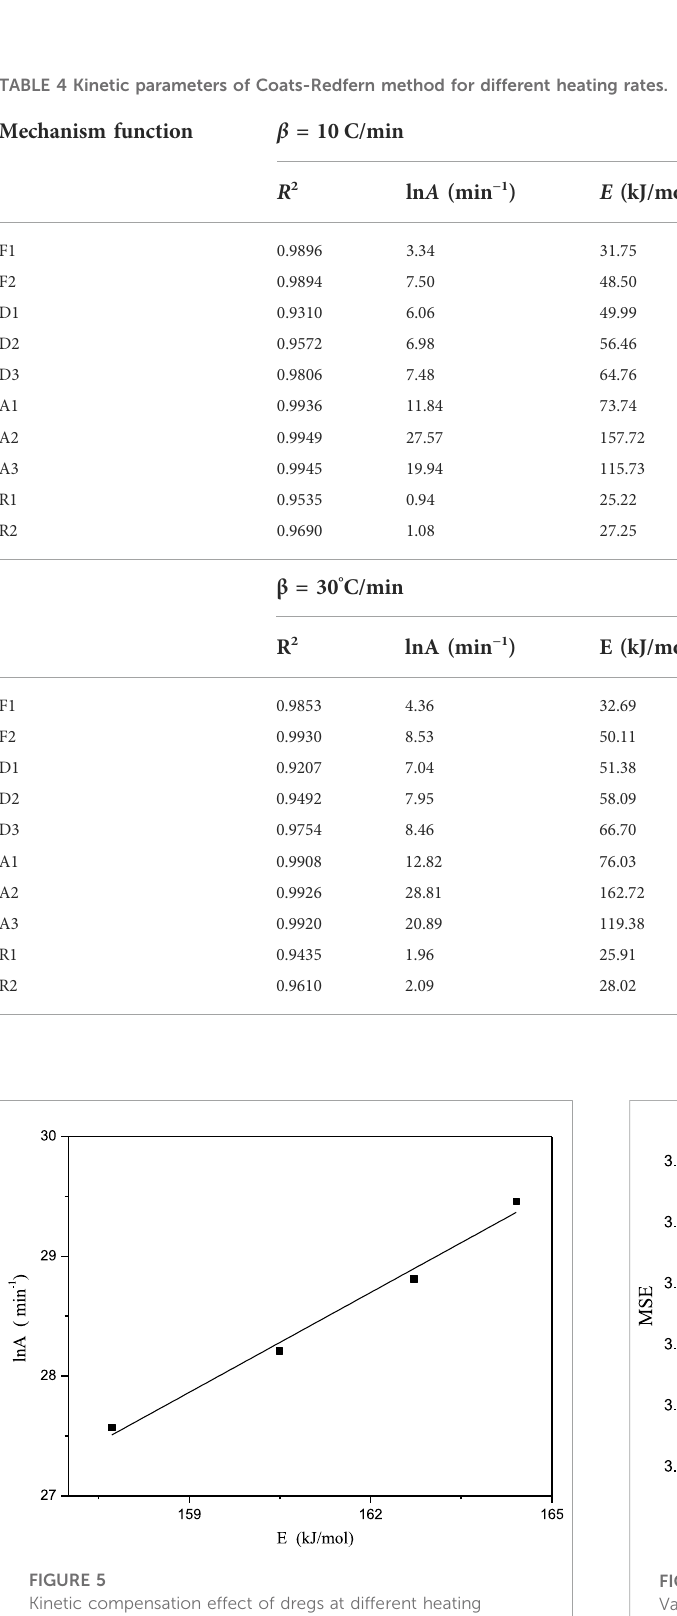
FIGURE 5 Kinetic compensation effect of dregs at different heating rates.